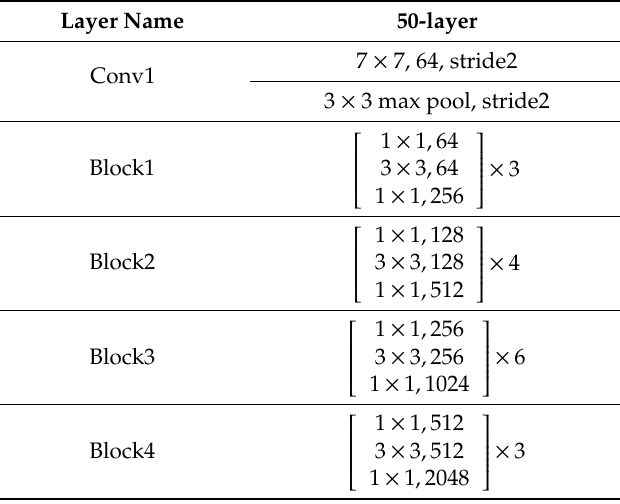
Table 2. Residual network block